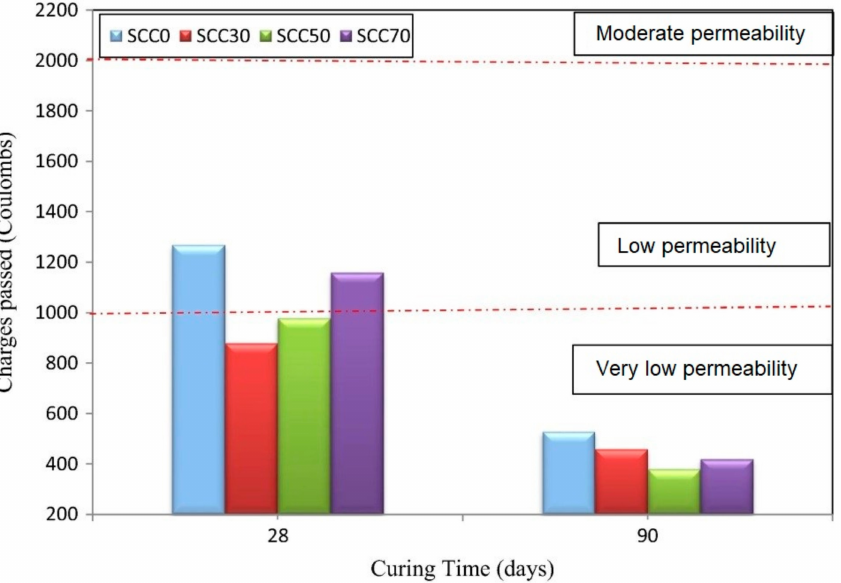
Figure 6. RCPT at 28 and 90 days [61]. Annotations: SCC contains 0% POFA, SCC30—30%, SCC50— 50%, SCC70—70%. Reprinted with permission from Elsevier